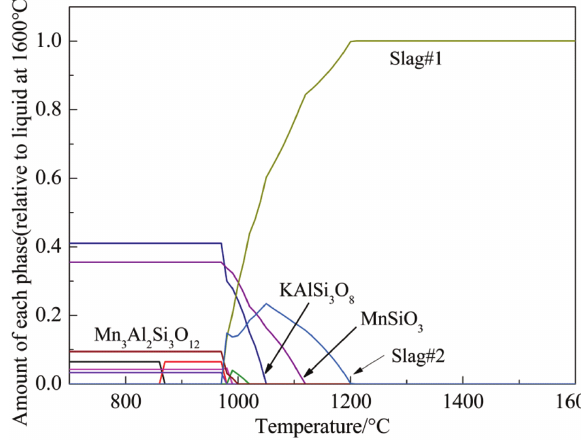
Figure 12: Phase translation of K 2 O-Al 2 O 3 -SiO 2 -MnO inclusions dur- ing cooling process (Heats b through